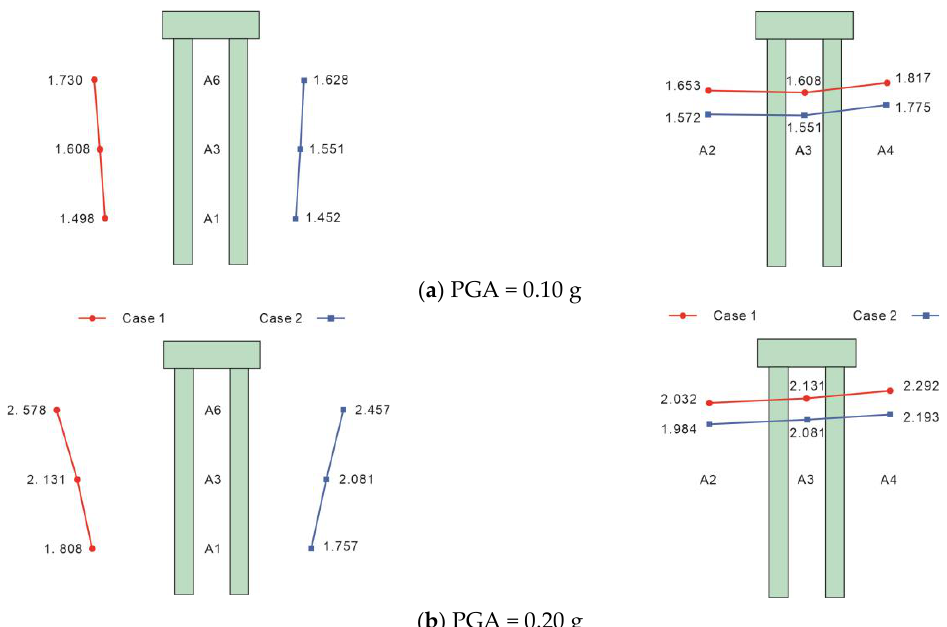
Figure 9. Distribution of the acceleration amplification factor along the vertical and horizontal di- rections.